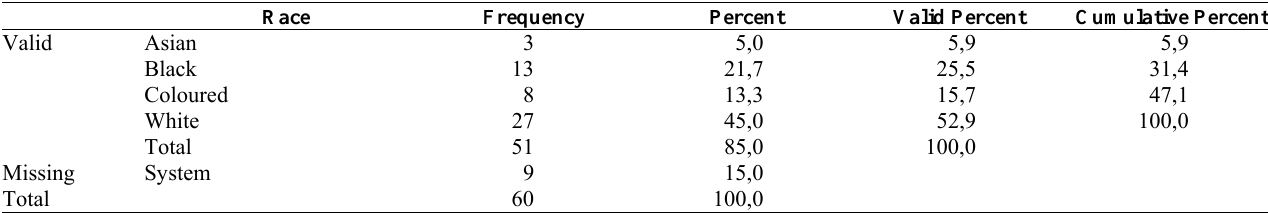
Table 4: Distribution of unit leader race